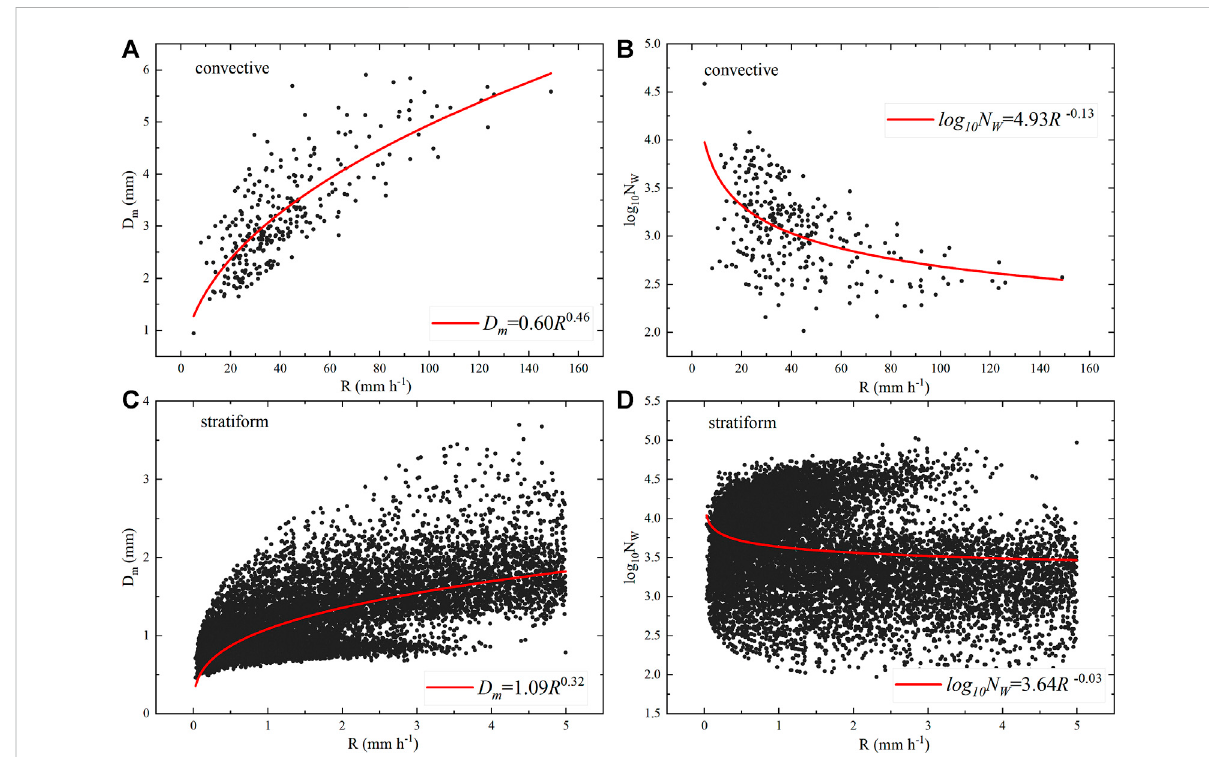
FIGURE 8 Scatter plots of D m vs. R and log 10 N w vs. R for convective (A,B) and stratiform (C,D) rain types. The solid red lines indicate the fi tting power-law relationships in the head watershed of Urumqi River using the least-squares method are also provided in each panel.